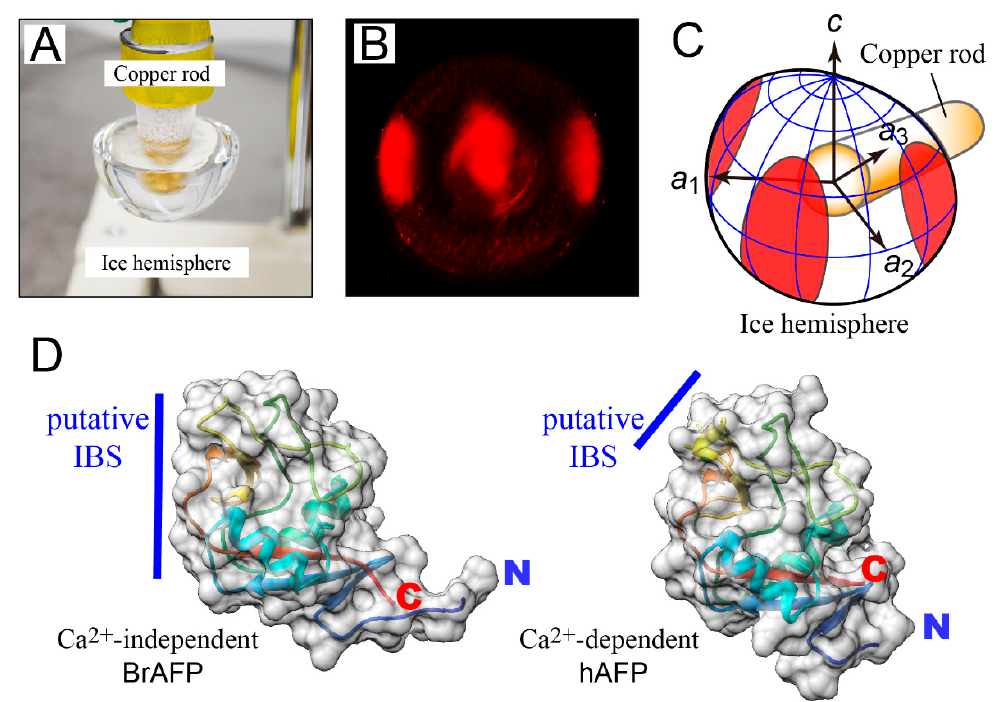
Figure 2. Analysis of fluorescence-based ice plane affinity (FIPA) and location of ice-binding site (IBS). ( A ) A single ice crystal hemisphere ( φ = 2 cm) mounted on a frosty copper rod so as to face down its 1st prism plane. This hemisphere is soaked into a 0.1 mg / mL solution of florescence-labeled jsAFP. ( B ) The FIPA pattern observed on the ice crystal hemisphere under ultra violet (UV) light. ( C ) Illustration to show the location of the FIPA pattern on the ice hemisphere. The 1st prism plane is a region flanked by a 1 - and a 2 -axes, on which jsAFP molecules are adsorbed. ( D ) Comparison of putative IBSs of Ca 2 + -dependent antifreeze protein (AFP) from herring (hAFP) (PDB ID: 2PY2) and Ca 2 + -independent AFP from longsnout poacher Brachyopsis rostratus (BrAFP) (PDB ID: 2ZIB) viewed from almost the same direction, in which ribbon models are superimposed. Compared with the large putative IBS contributed by G57, I58, and a segment from P87 to H118 formed in BrAFP, a small IBS consisting of Q92, D94 E99, and D113 was assumed for hAFP.